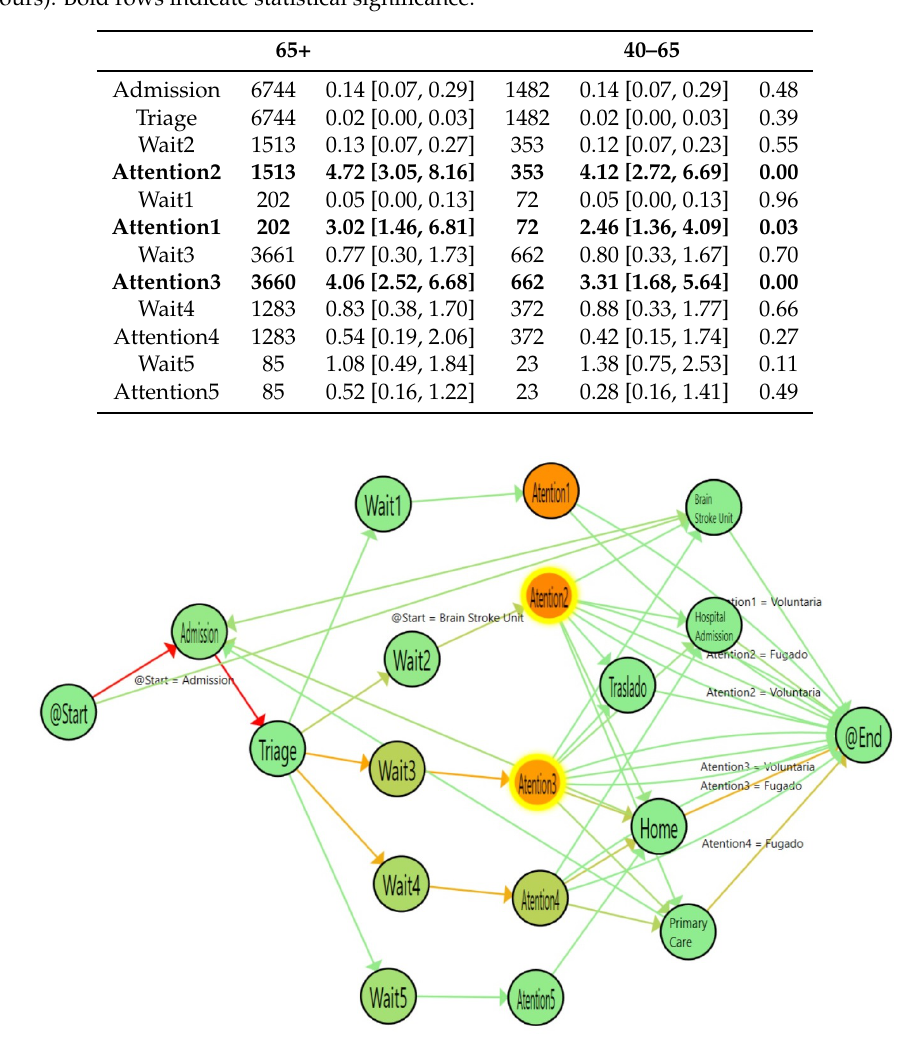
Table 4. Analysis of Statistical Significance between the 65+ and 40–65 age groups (Interquartile range in Hours). Bold rows indicate statistical significance.